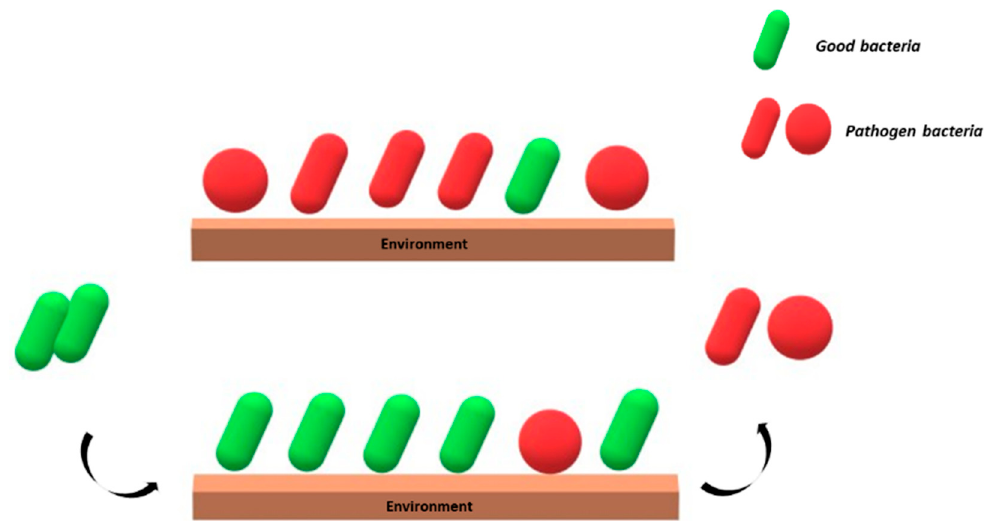
Figure 1. Schematic representation of the “Bygiene” principle. Good bacteria (green) introduced from the outside counteract the colonization of the environment by potential pathogens (red).